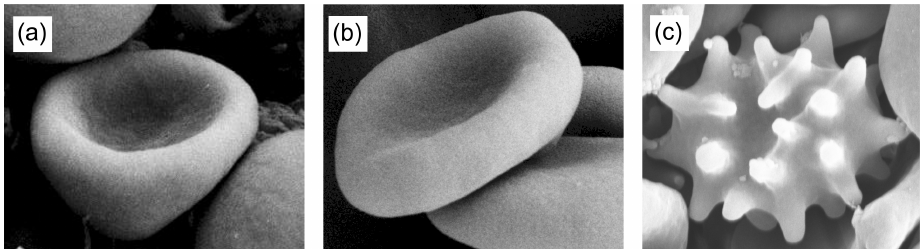
Figure 9. Scanning electron microscope images of red blood cells (RBC) shapes: ( a ) open stomatocyte, ( b ) discocyte, ( c ) echinocyte. Adapted with permission from ref. [137]. 2019 Springer